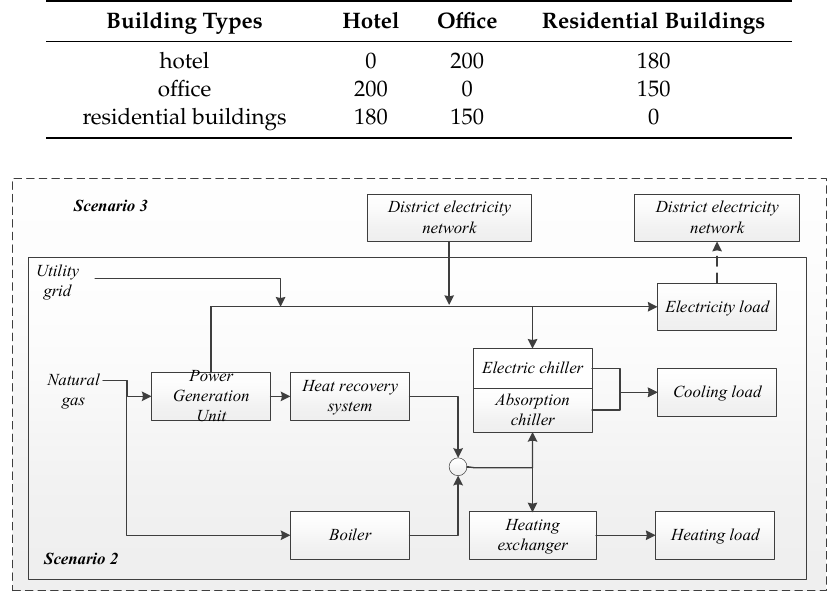
Figure 2. The superstructure of distributed energy system ( scenario 2 ) and system integrated with electricity network ( scenario 3 ).